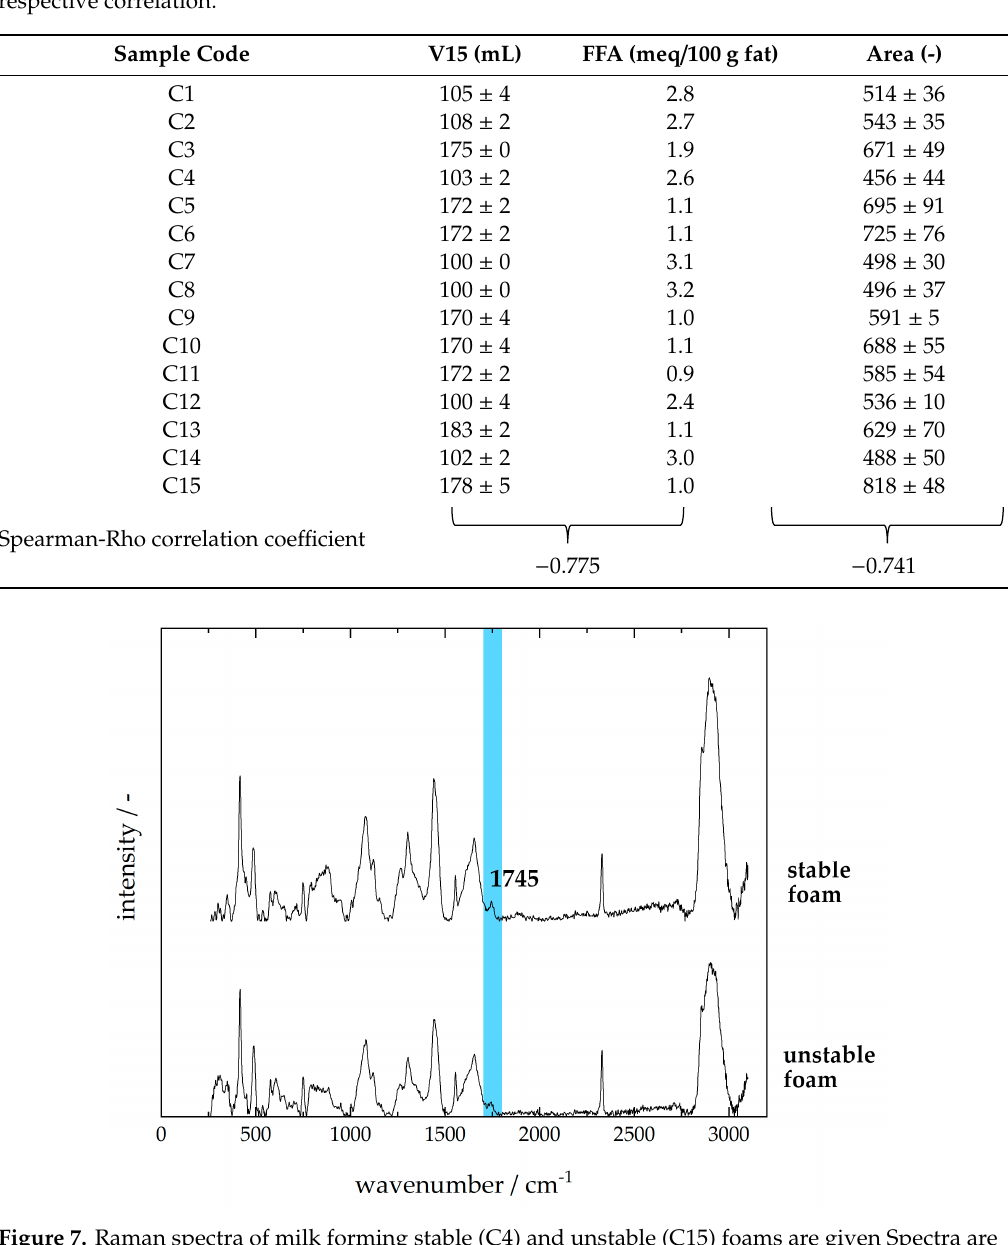
Figure 7. Raman spectra of milk forming stable (C4) and unstable (C15) foams are given Spectra are offset for clarity. Highlighted in blue is the peak corresponding to the ν(C=O) stretching vibration in an ester. The blue bar marks the band at approximately 1745 cm − 1 , corresponding to the ν(C=O) stretching vibration in an ester [33,34,36]. During lipolysis, the ester bond of triacylglycerides is broken down, resulting in nonesterified fatty acids and partial glycerides or glycerol. Hence, the intensity of the band co rresponding to the ν(C=O) stretching vibration in an ester decreases with decreasing amount of triglycerides and therefore, with increasing rate of lipolysis and increasing FFA content. The area under the band was determined for all samples. The results are shown in Table 2. Spectra were smoothed (second-order polynomial) in the spectral range from 1720 to 1775 cm − 1 prior to determining the area. A statistically significant correlation with a Spearman-Rho correlation coefficient of − 0.741 between the area and FFA content was found. Additionally, correlation of the area and total volume after 15 min was statistically significant resulting in a correlation coefficient of − 0.799. Foam stability was strongly influenced by the FFA content. Future research could focus on the implementation of quantitative models to determine the amount of free fatty acids on-line. Spectra could also be used to qualitatively predict the foaming properties of the milk by assessing deviations from standard spectra.